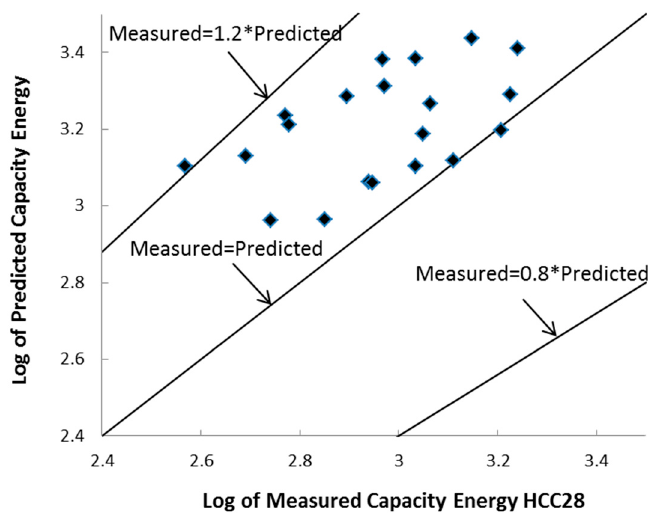
Figure 7. Capacity energy predicted by RSM equation on the basis of half central composite (HCC) design of experiment (DOE) and the second ANN model versus the measured values of laboratory tests.